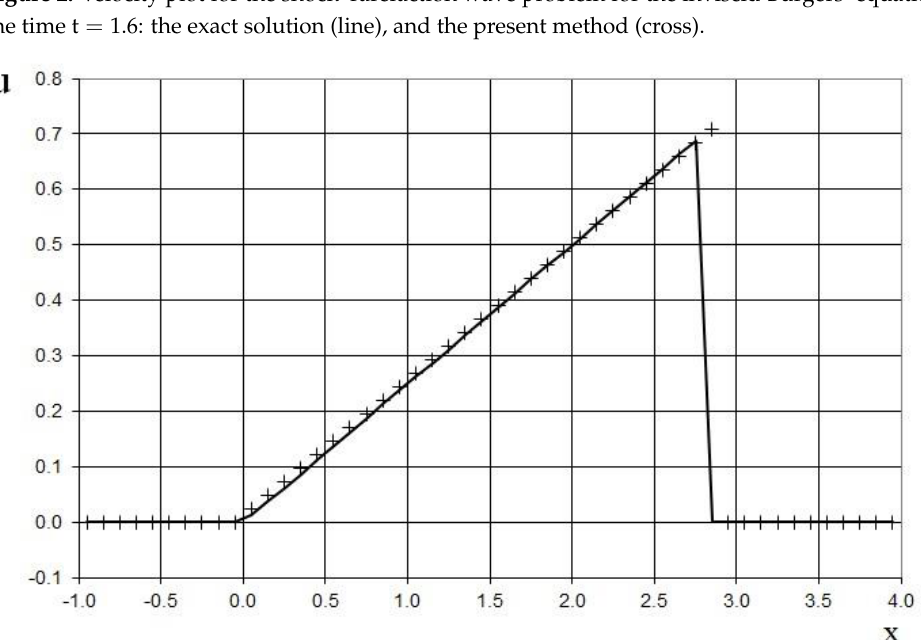
Figure 3. Velocity plot for the shock–rarefaction wave problem for the inviscid Burgers’ equation at the time t = 4.0: the exact solution (line), and the present method (cross).